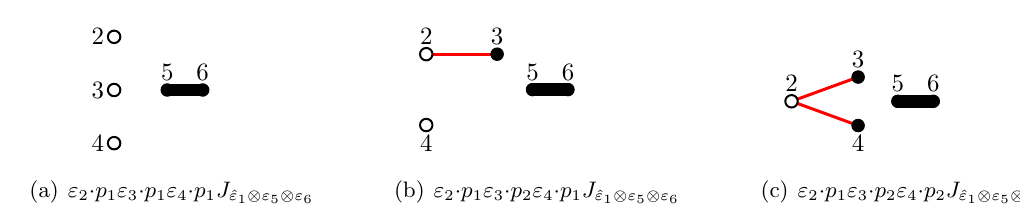
Figure 4 . Typical monomials of disconnected topologies at seven